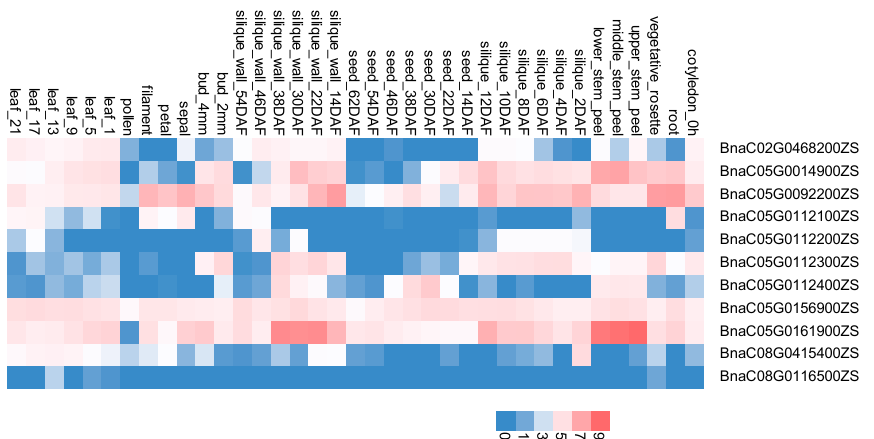
Figure 3. Expression heat map of candidate genes for hemicellulose content in stalk and taproot of Brassica napus . The expression amount is transformed by log 10 (x + 1).